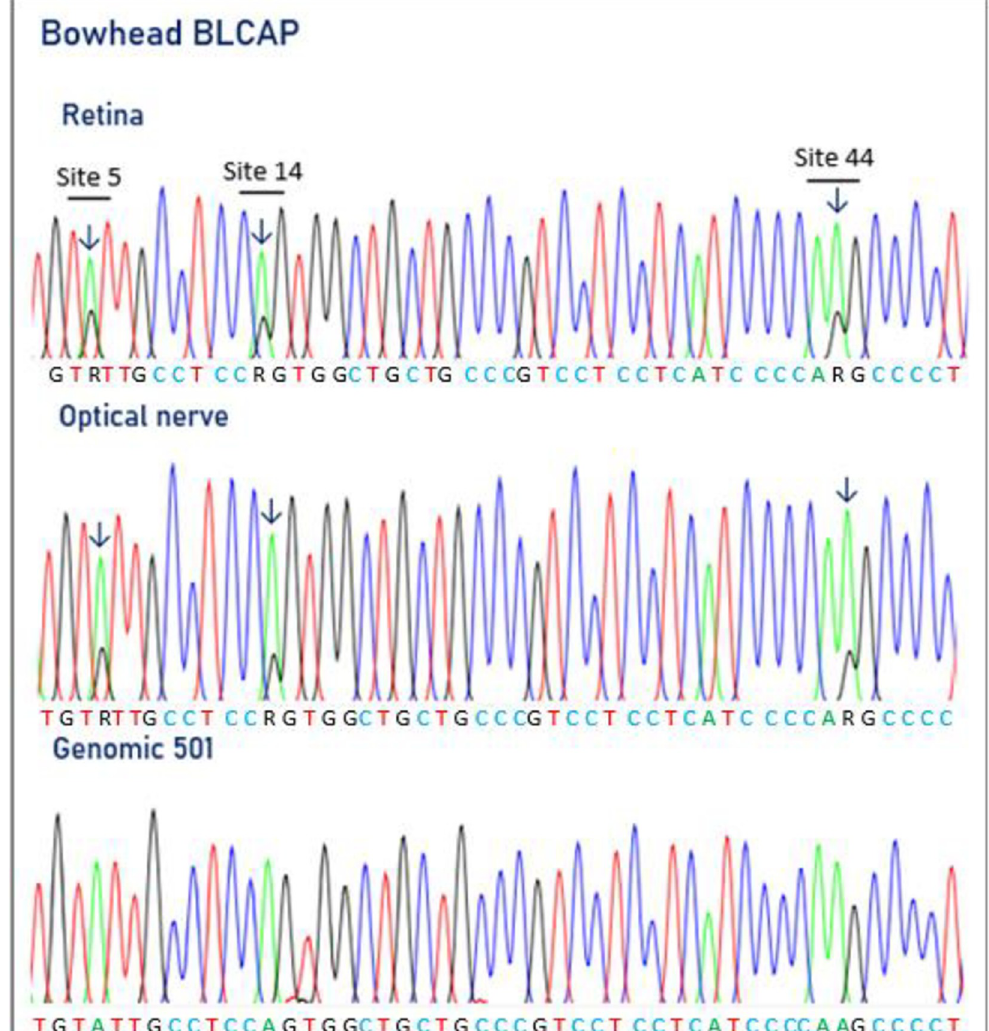
Fig 4. Electropherograms showing BLCAP pre-mRNA editing in bowhead retina and optical nerve. For comparison, the genomic sequence is shown below. Electropherograms showing editing in retina (upper panel) and optical nerve (middle panel). The adenosines subject to editing, in sites 5, 14 and 44, are indicated by arrows.